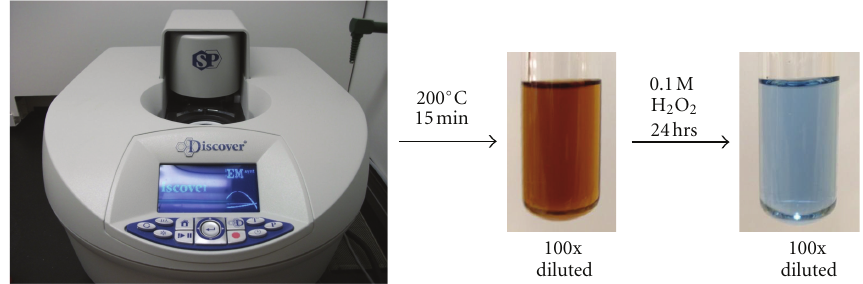
Figure 1: Schematic of microwave synthesis and chemical oxidation of MoO x nanoparticles. A mixture of molybdenum oxide bis(acetylacetonate) in n -butanol was placed in a microwave reactor (CEM Discover) and heated using 2.45 GHz radiation. When heated at 200 ◦ C for 15 minutes, MoAcAc reacted, forming a brown suspension of nanoparticles. Chemical oxidation of the nanoparticle suspension with 0.1 M H 2 O 2 for 24 hours yielded a blue suspension of nanoparticles.